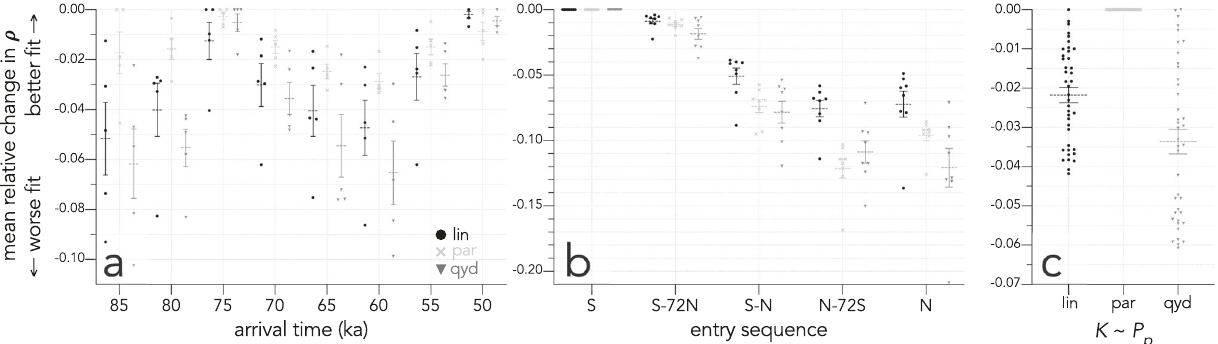
Fig. 2 Correlation differences between fi rst-arrival scenarios and archaeological dates. Relative reduction in Spearman ’ s ρ rank correlation between the predicted time of fi rst arrival over all grid cells for each scenario and the Signor – Lipps- and spatial-bias-corrected archaeological map layer. Holding all other input parameters equal, the mean relative change in average ρ is expressed as a function of modifying a arrival time (from 85 to 50 ka, in 5000-year increments; fi ve scenarios for each increment), b entry-point sequence (S = southern route through the Sahul Shelf; N = northern route through Bird ’ s Head of New Guinea, and combinations of these with lags expressed in terms of human generations: 72 generations ~2000 years; 8 scenarios each), and c assumed relationship between human carrying capacity ( K ) and hindcasted net primary production ( P p ) (lin = linear; par = rotated parabolic; qyd = reciprocal quadratic yield density — see details in ‘ Methods ’ ; three scenarios each). The horizontal bars represent the mean relative change in ρ and the error bars represent standard errors of the